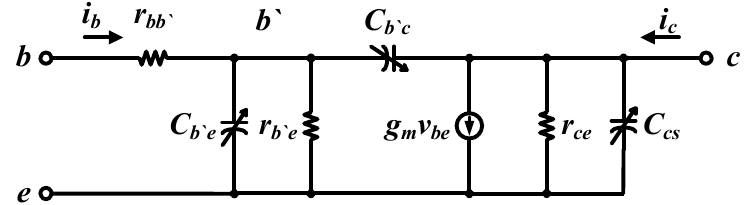
Figure 3. Device model of the HBTs (Heterojunction Bipolar Transistors).